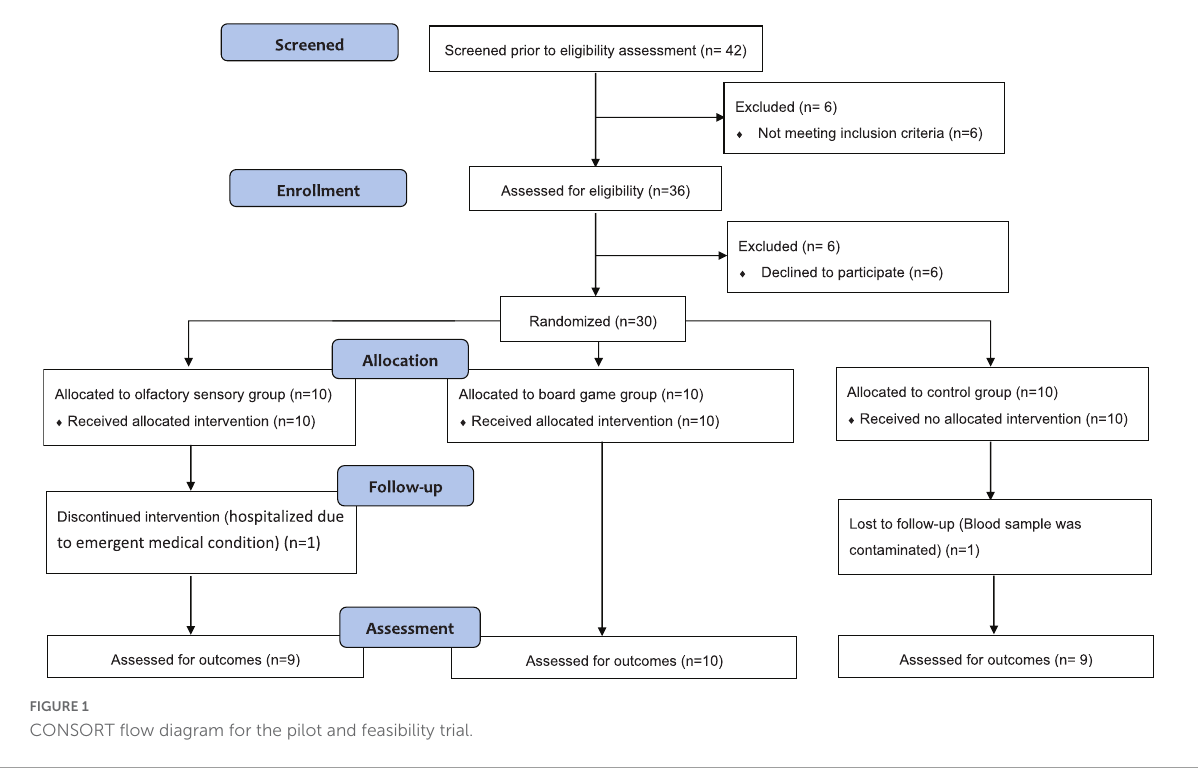
FIGURE1 CONSORT flow diagram for the pilot and feasibility trial.